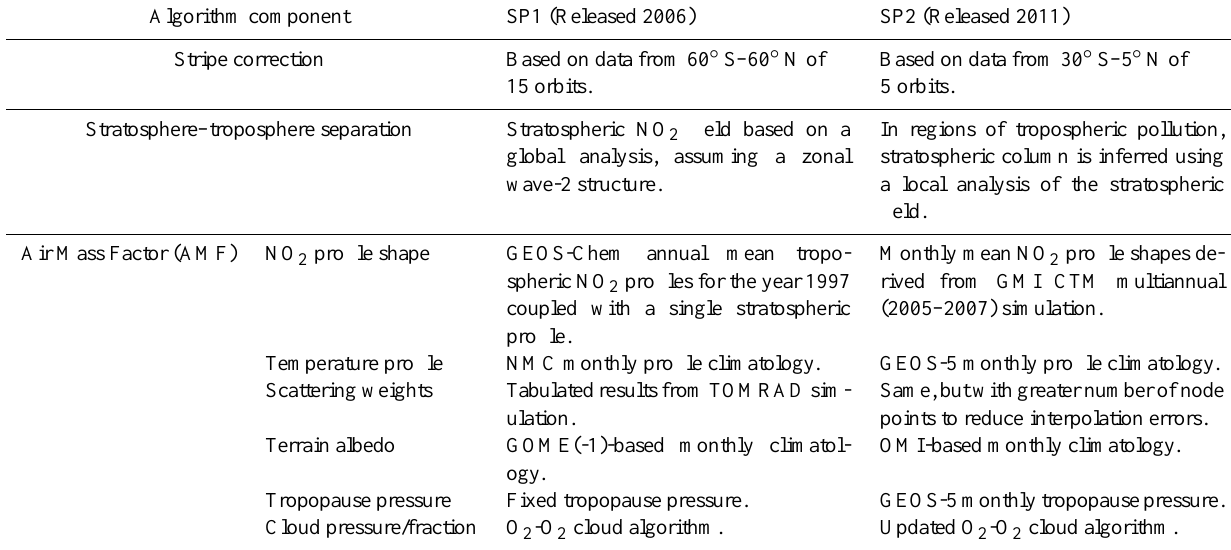
Table 1. Comparison of SP1 and SP2. Algorithm